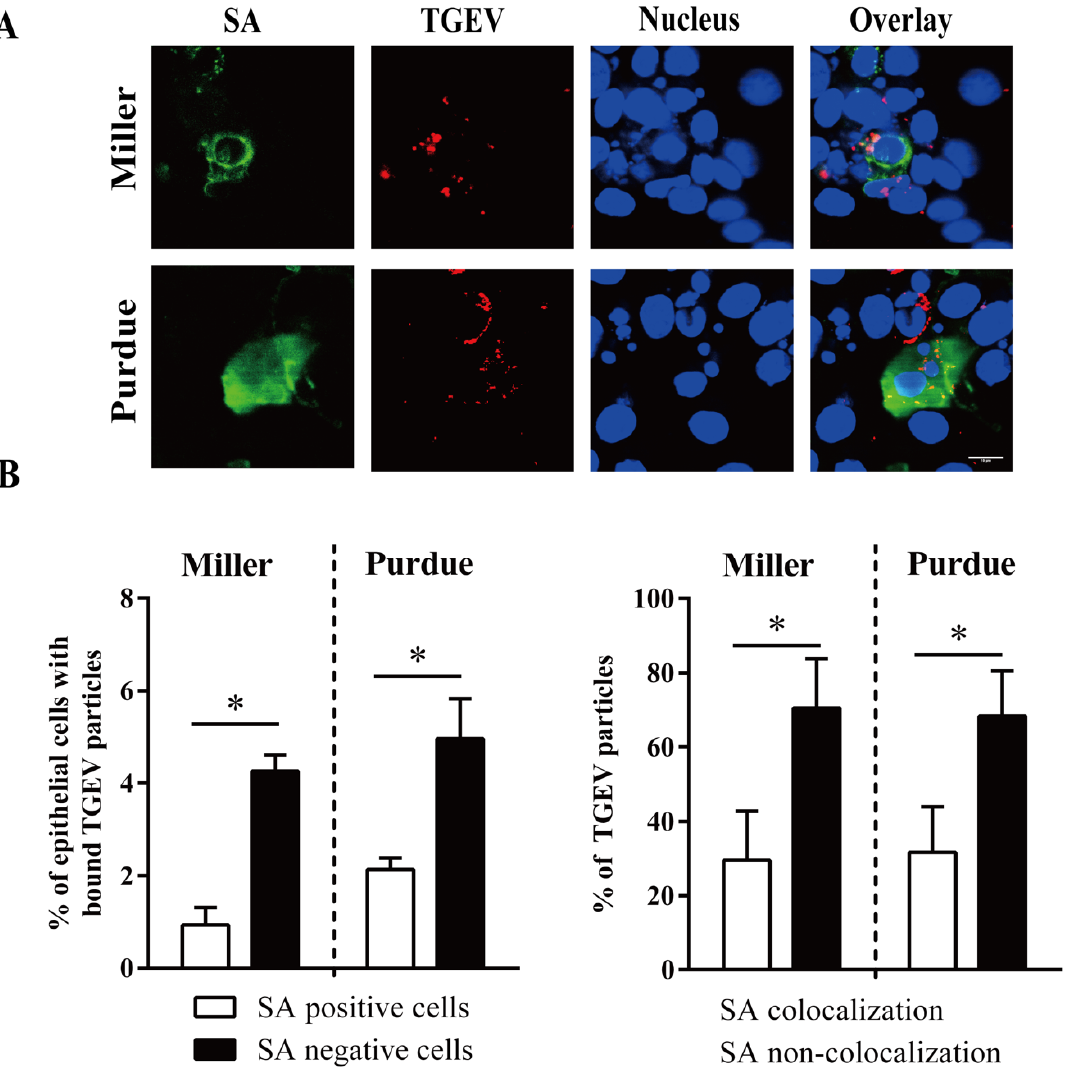
Figure 8. TGEV binds to sialic acid (SA) positive/negative enterocytes. Primary enterocytes were inoculated at 4 °C with TGEV particles (m.o.i. = 10). ( A ) Double immunofluorescence staining of TGEV particles bound to SA positive/negative cells. Scale bar: 10 µm. ( B ) The percentage of cells with bound virus particles (left panel). The percentage of SA colocalized TGEV particles was counted based on five random fields (right panel). Data are expressed as the mean ± SD of the results of three separate experiments. Statistically significant differences are indicated as * p < 0.05.